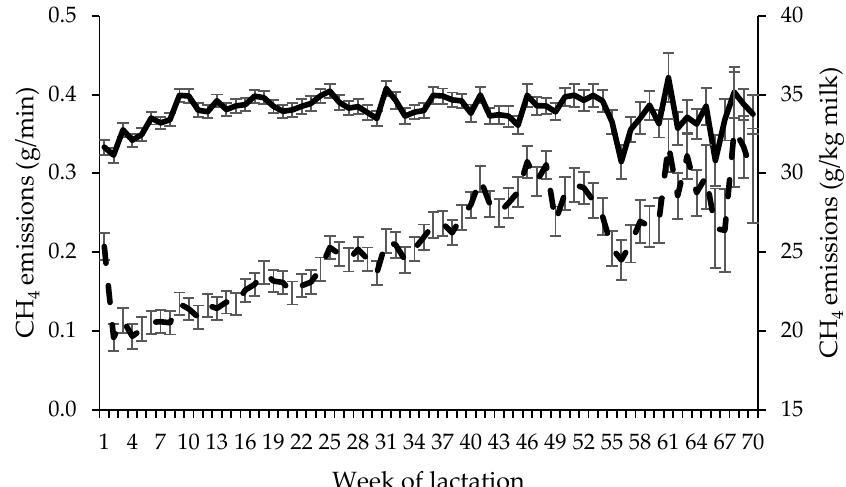
Figure 2. Estimated mean (with s.e. bars) CH 4 emission rate (g/min; solid line) and per kg milk (dashed line) from week 1 to 70 of lactation.